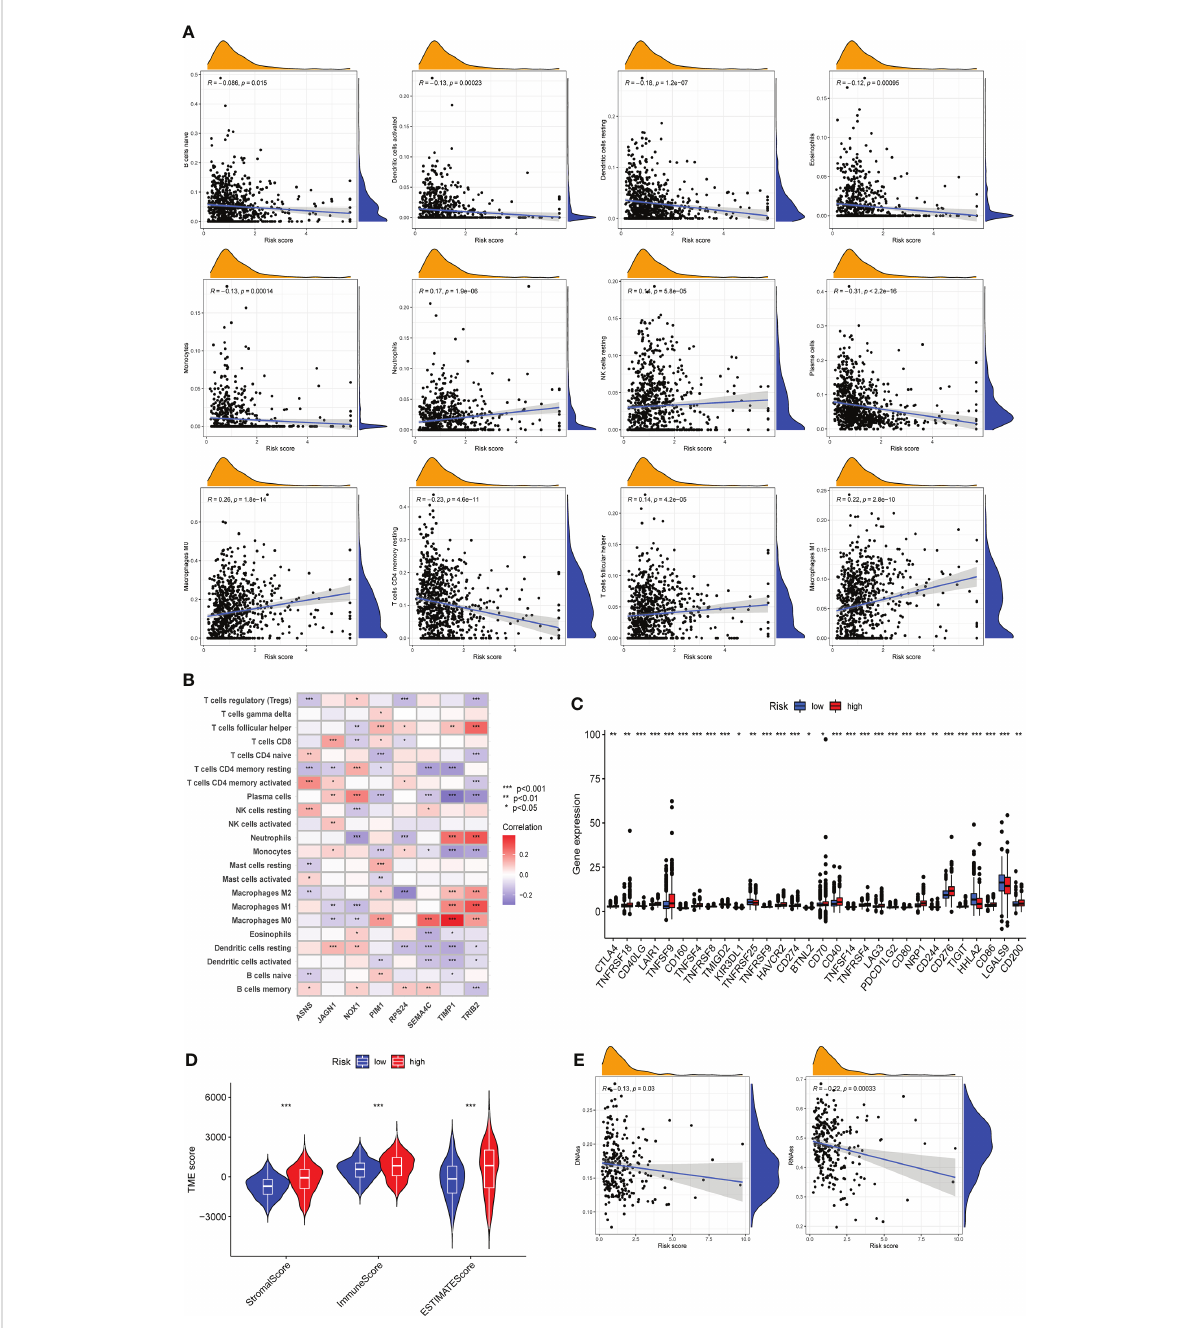
FIGURE 7 Assessment of tumor microenvironment (TME) and immune in fi ltration between different risk groups. (A) CIBERSORT algorithm reveals the correlation of risk score and immune cell subtypes. (B) Correlation between 8 candidate genes and immune cell abundance. (C) Expression levels of immune checkpoints in high-risk and low-risk groups. (D) Differences of Stromal score, Immune score and ESTIMATE score between the two risk groups. (E) Correlation of two cancer stemness cell indices (RNAss and DNAss) with risk score. Adjusted p-values were shown as * P < 0.05, ** P < 0.01, *** P <